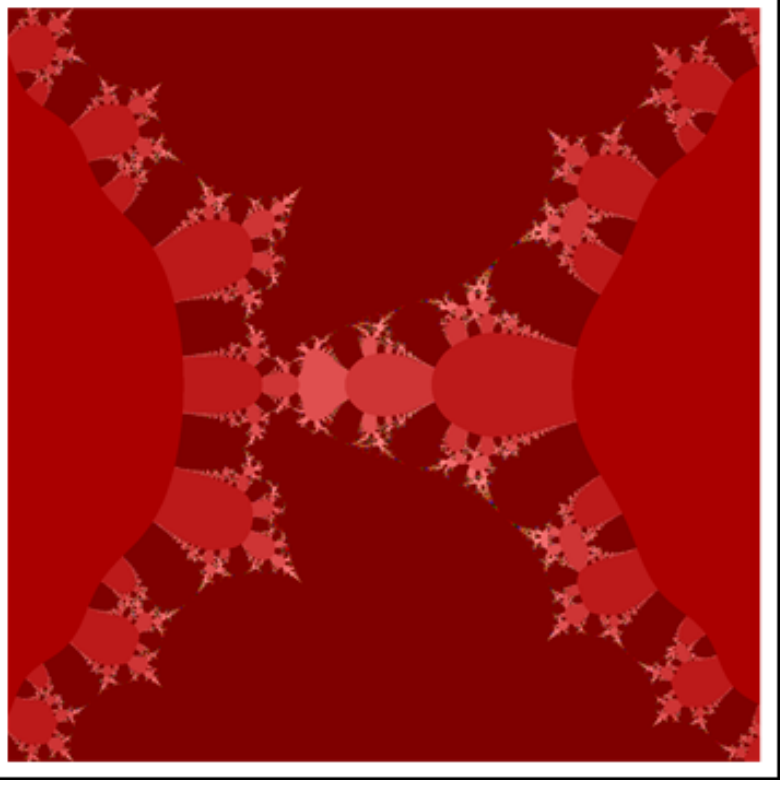
Figure 31. M-set for τ ( z ) = e z 2 + c via DKIS. The image execution time is 229.6